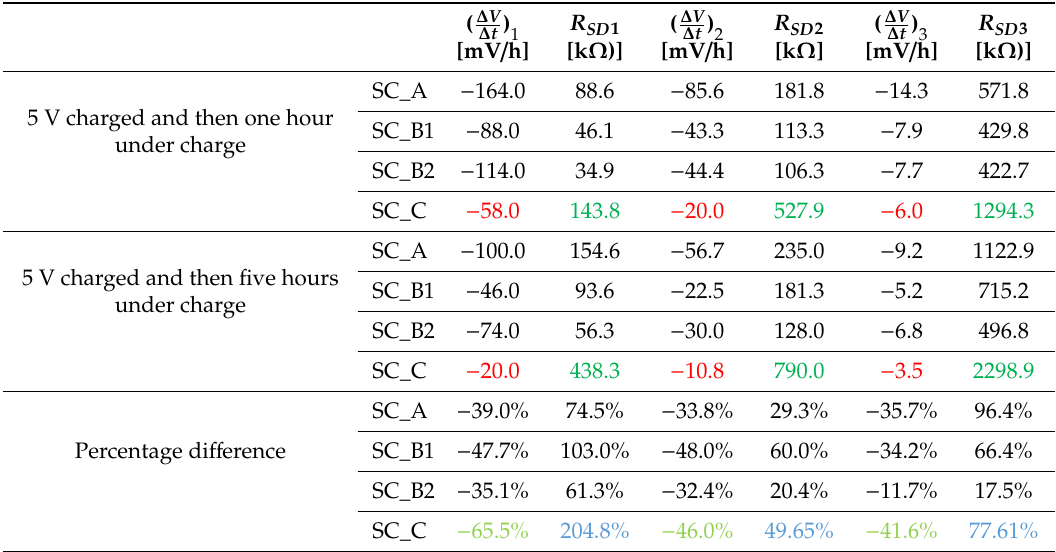
Table 4. Comparison of self-discharge rate and R SD resistance values for the characterized SCs relatively to the one hour and five hours under charge cases at 5